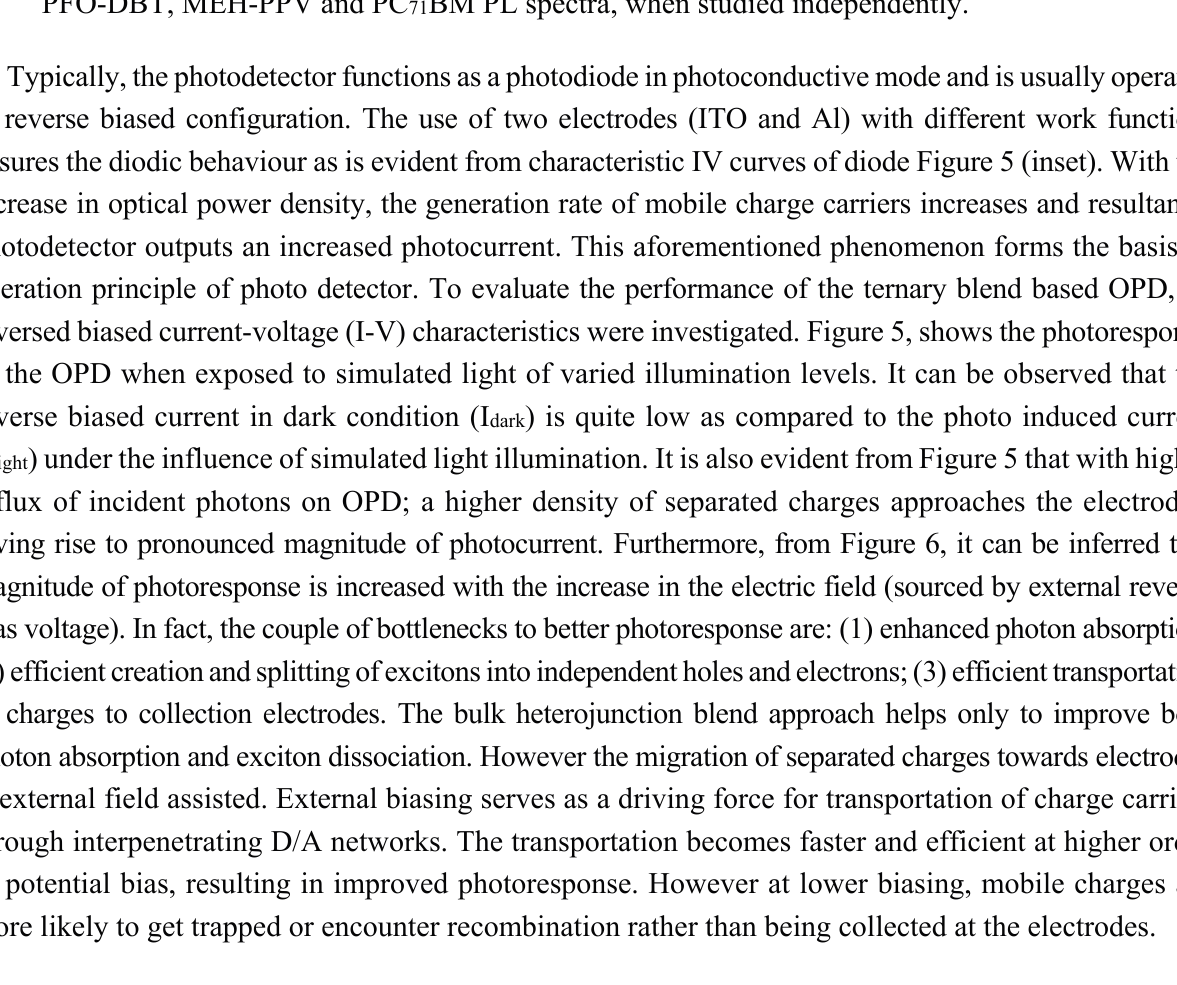
Figure 4. PL spectra of PFO-DBT: MEH-PPV blends at different volumetric ratio. (Inset) PFO-DBT, MEH-PPV and PC 71 BM PL spectra, when studied